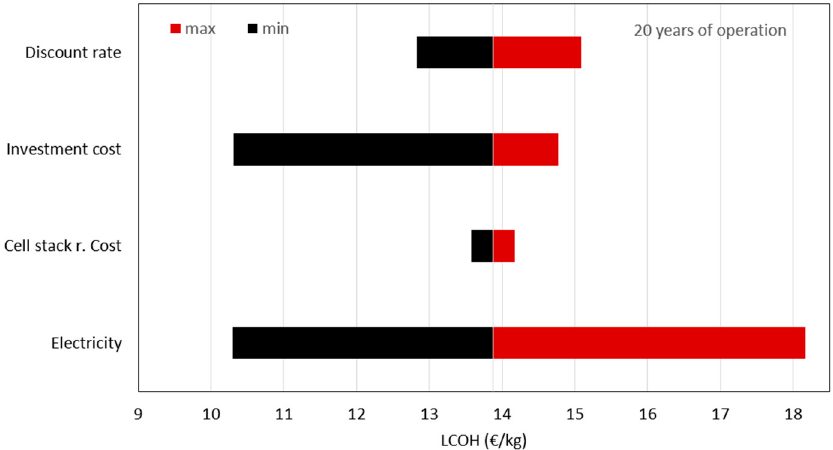
Figure 9. Sensitivity analysis for 20 years of lifetime.